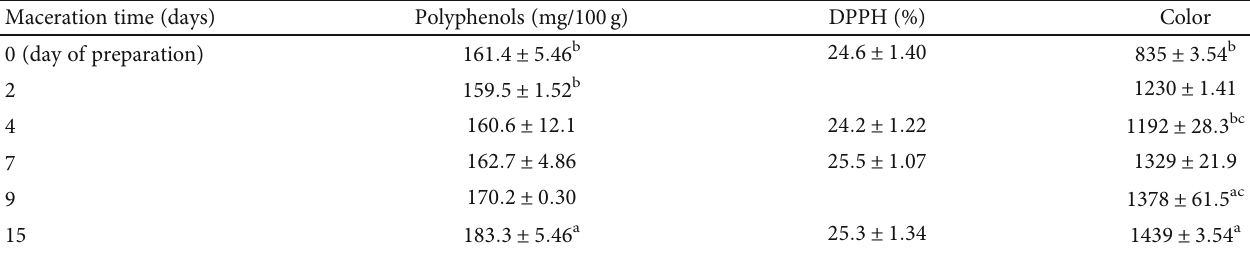
Table 2: Polyphenol content, antioxidant activity DPPH, and color in the macerate depending on the time of maceration. Maceration time